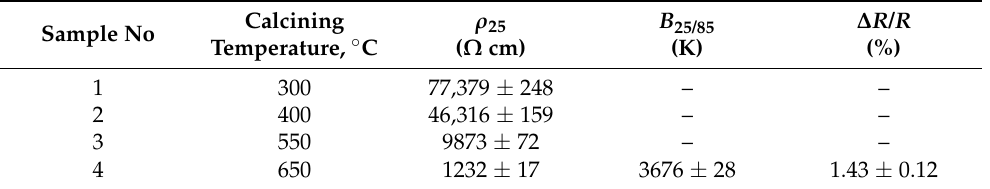
Table 3. The electrical properties of ceramics sintered at 1100 ◦ C. Sample No